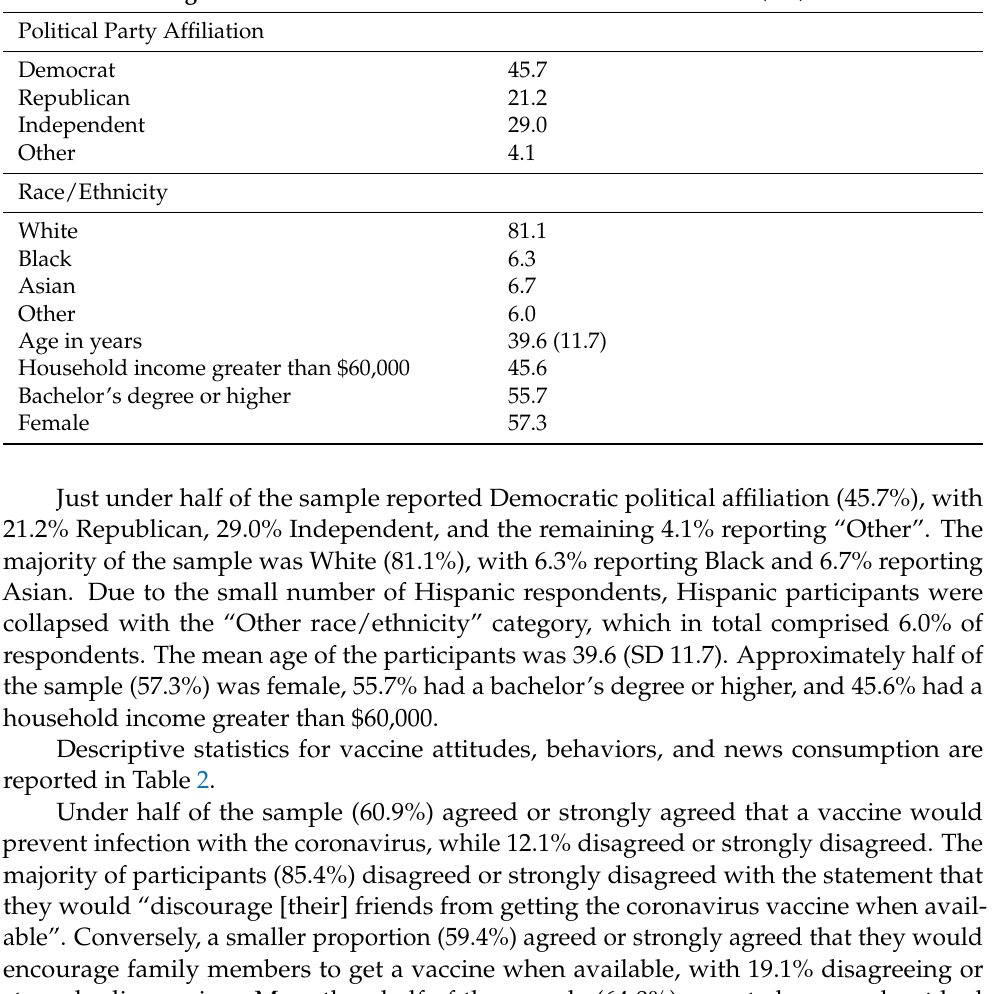
Table 1. Sociodemographic characteristics of the study population for a national survey on trusted sources of COVID-19 vaccine information in the US, 2020 ( N = 586). Background Variables % Mean